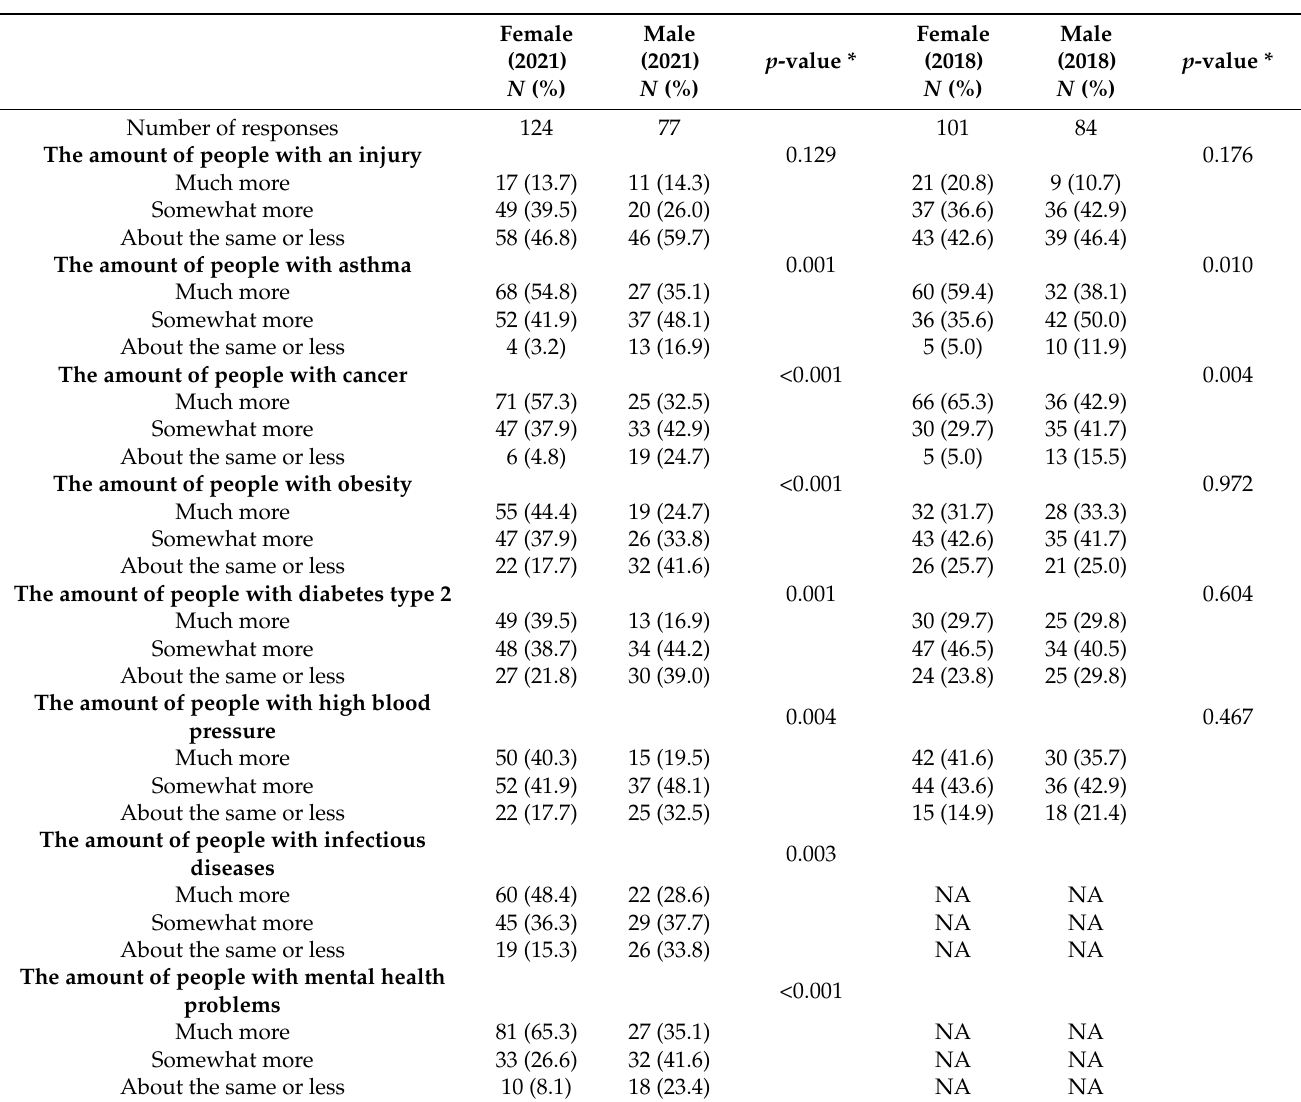
Table 3. Perceived frequency of health issues in next ten years, by sex, in 2018 and 2021 survey question: “With environmental factors such as climate change, pollution, and toxic waste in mind, how often do you think the following health issues will occur in ten years compared to now in